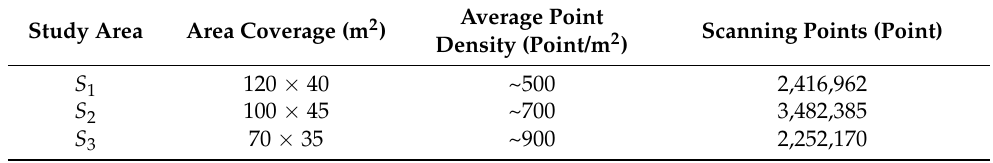
Table 2. Point cloud data information statistics